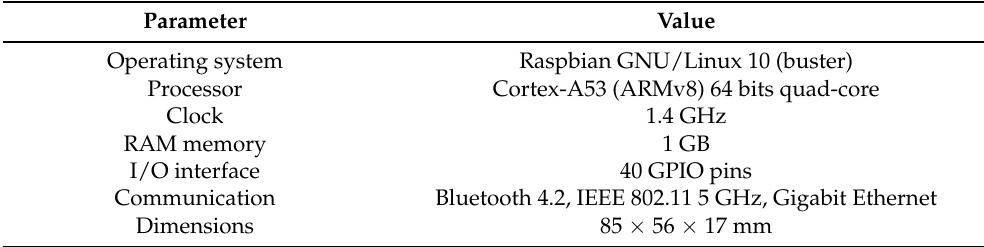
Table 1. Main features of the Raspberry Pi used in this investigation (Raspberry Pi 3 Model